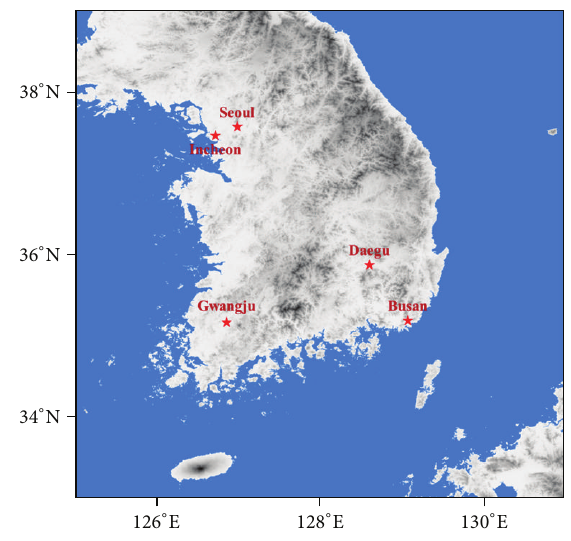
Figure 1: Topography and geographic locations of the five cities in Republic of Korea used in this study. Table 1: Geographic characteristics of the five cities used in this study.